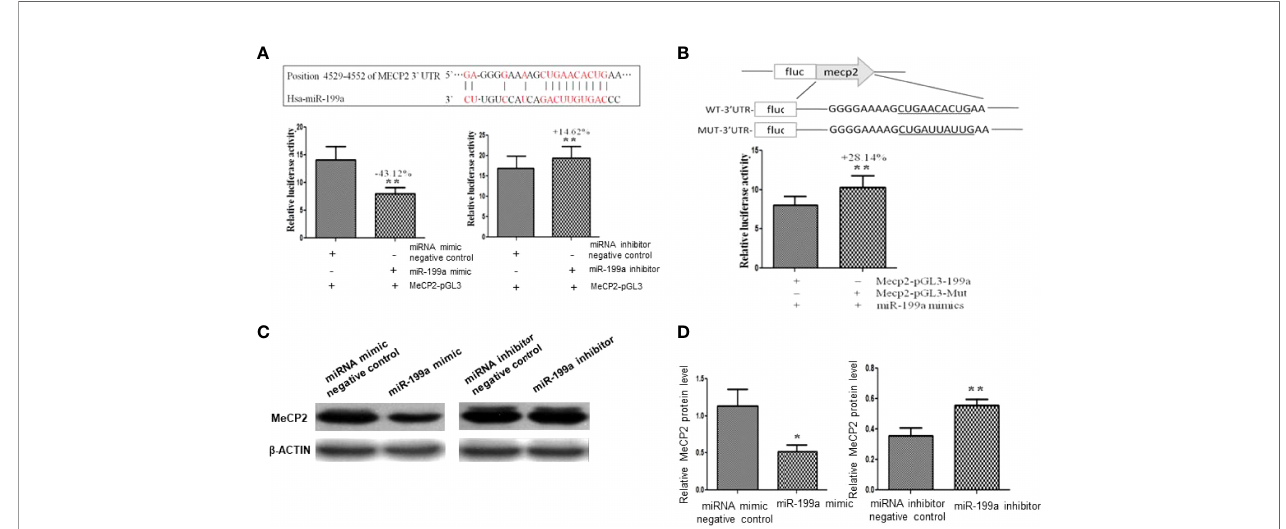
FIGURE 3 | Target gene veri fi cation of miR-199a. (A) Prediction of the binding site of miR-199a and the 3 ’ -UTR of MeCP2 mRNA and dual-luciferase detection of the target gene interaction relationship between miR-199a and the 3 ’ -UTR of MeCP2 mRNA. n=3. (B) The inhibitory effect of miR-199a on MeCP2 was signi fi cantly reduced after induction of point mutations to the binding site. n=3. (C, D) Western-blot veri fi cation of the regulatory effect of miR-199a on the protein level of the target gene MeCP2. * P <0.05, ** P <0.01.